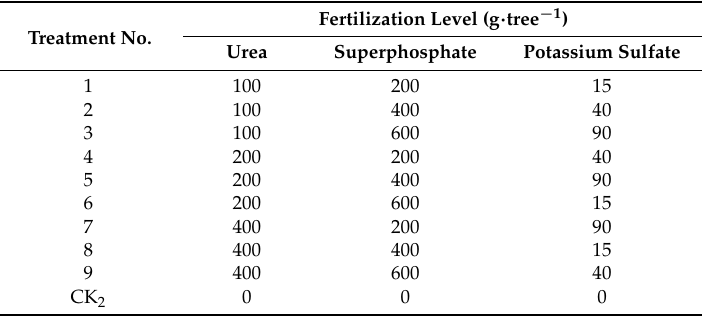
Table 1. Orthogonal trial fertilizer